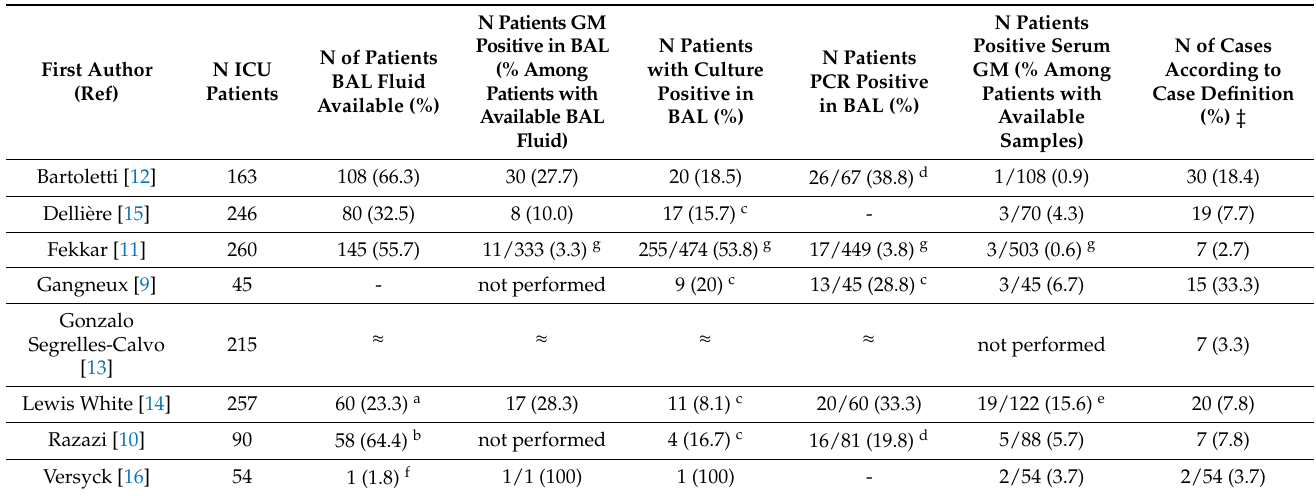
Table 3. Mycological